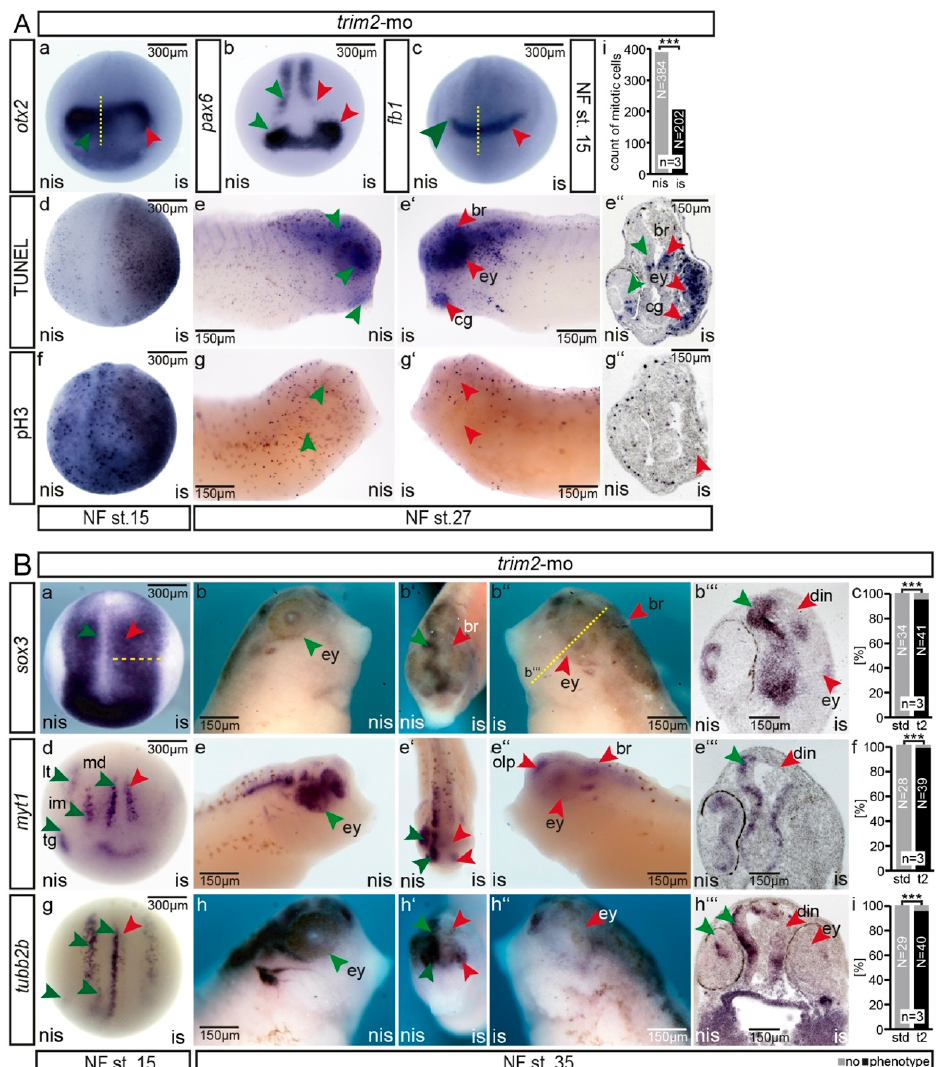
Figure 4. ( A ) Suppression of trim2 function a ff ected cell proliferation and cell survival within the forming CNS of tadpoles. (a-c; otx2 : strd-mo n = 10E; trim2 -mo n = 12E; p = 1.85E-05, unpaired χ 2 test, χ 2 = 18.33, degrees of freedom (df) = 1, po = 11, p < 0.001; fb1 : strd-mo n = 10E; trim2 -mo n = 12E; p = 2.73E-06, χ 2 = 22, df = 1, po = 12). At NF stage 15, early forebrain marker gene expression ( otx2 , pax6